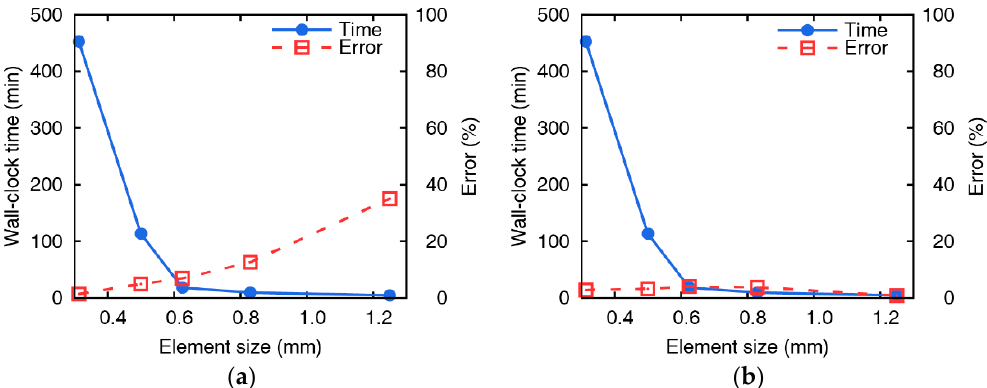
Figure 15. Wall-clock time and residual velocity error versus element sizes using ( a ) the Johnson-Cook damage model and ( b ) the EDFS ( v i = 163.2 m/s and t pl = 5 mm ).